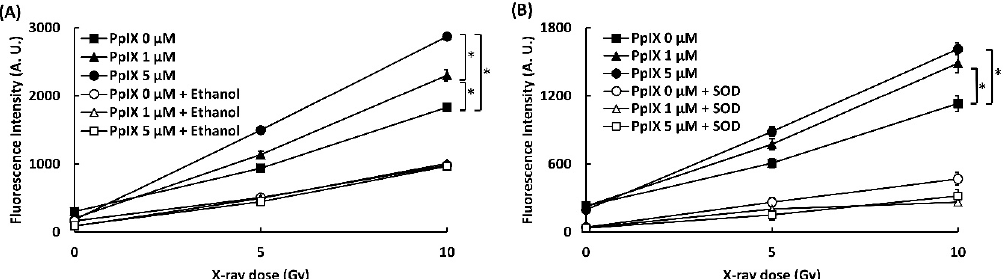
Figure 1. PpIX (protoporphyrin IX) enhanced ROS generation by X-ray irradiation. (A) • OH measured by 3’-(p-aminophenyl) fluorescein (APF). Ethanol was used as a scavenger for • OH. (B) O